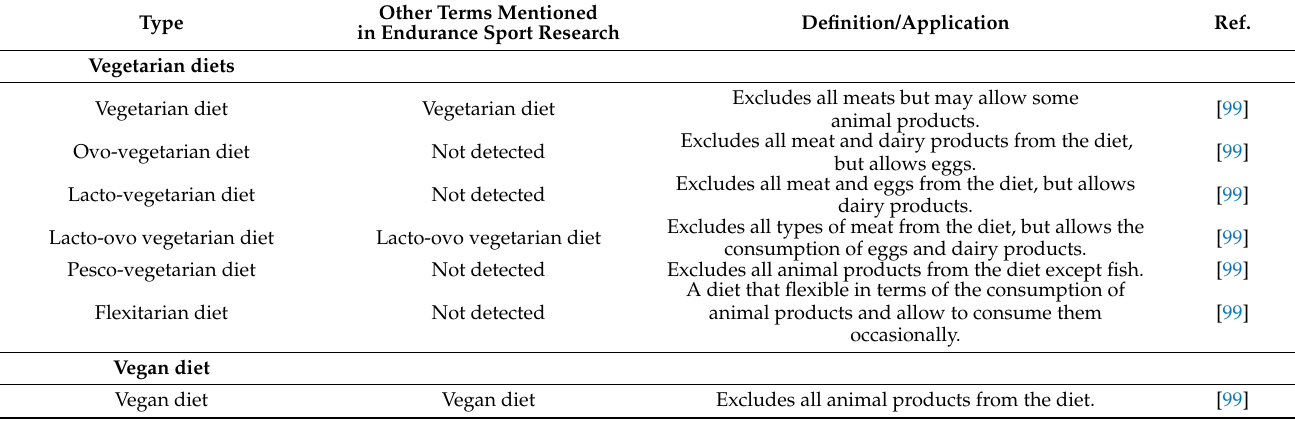
Table 2. Types and application processes of new diets applied by endurance